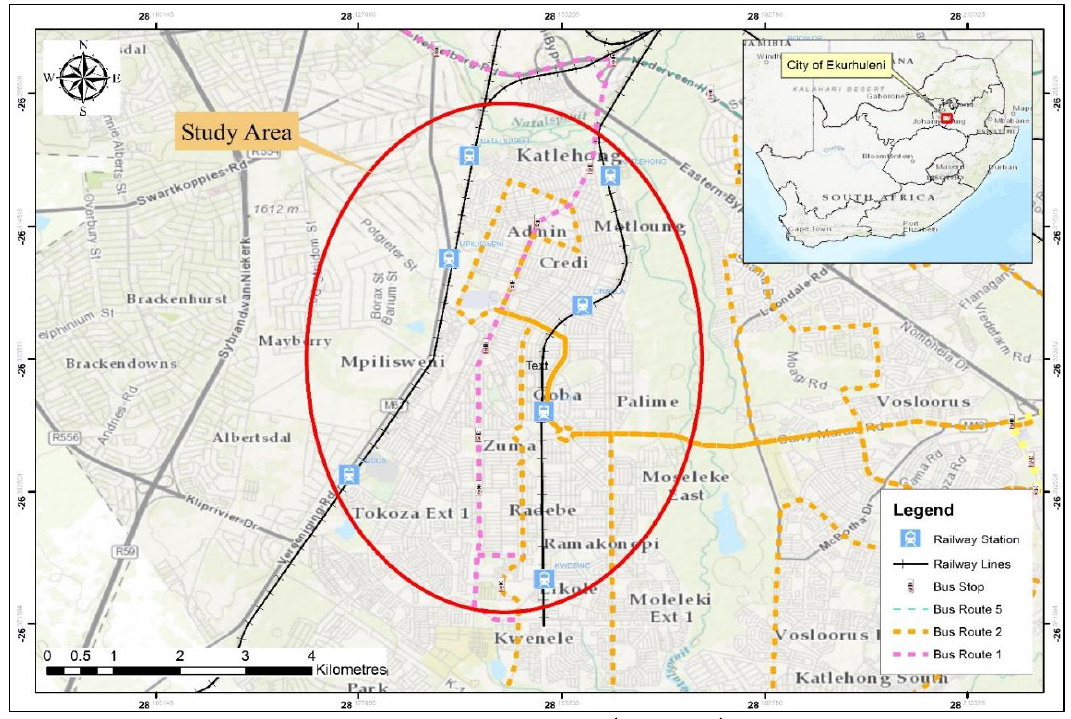
Figure 2: Katlehong (Study